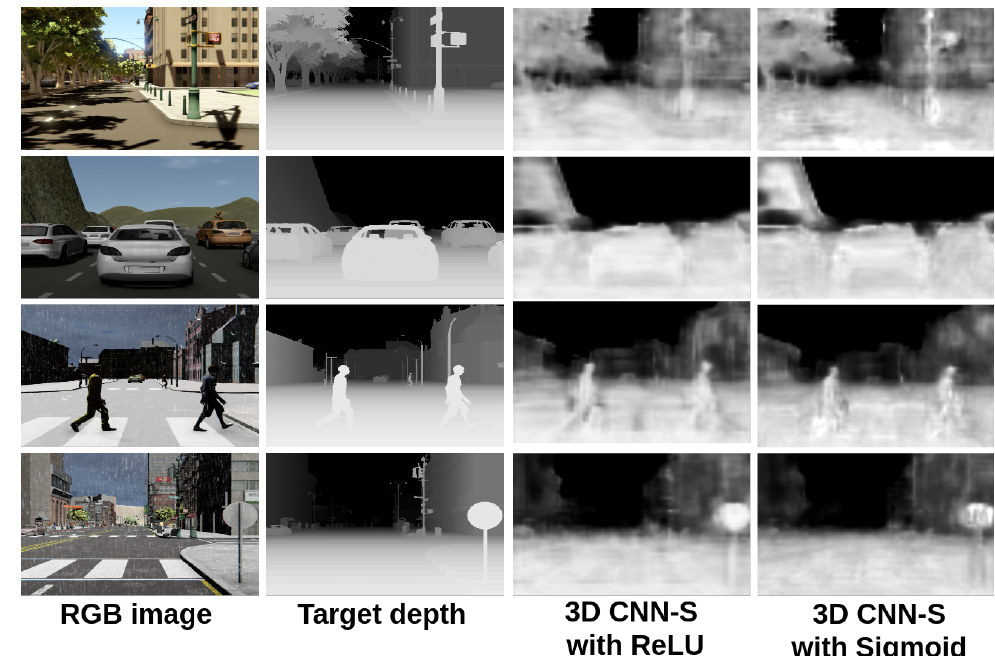
Figure 16. Results obtained with the 3D CNN-S model (visually